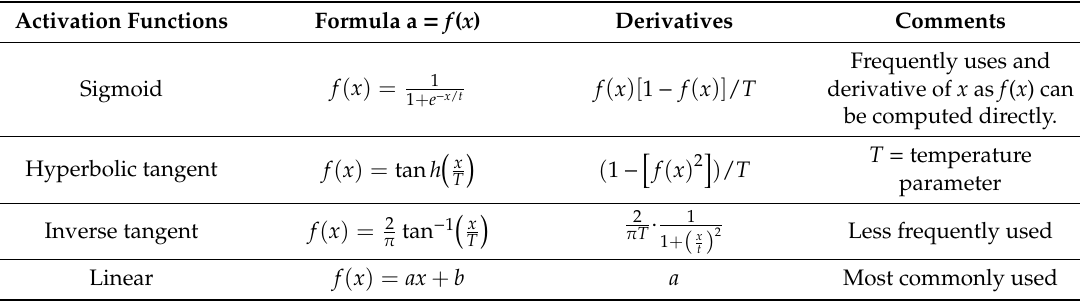
Table A3. Summary of neural network activation functions.